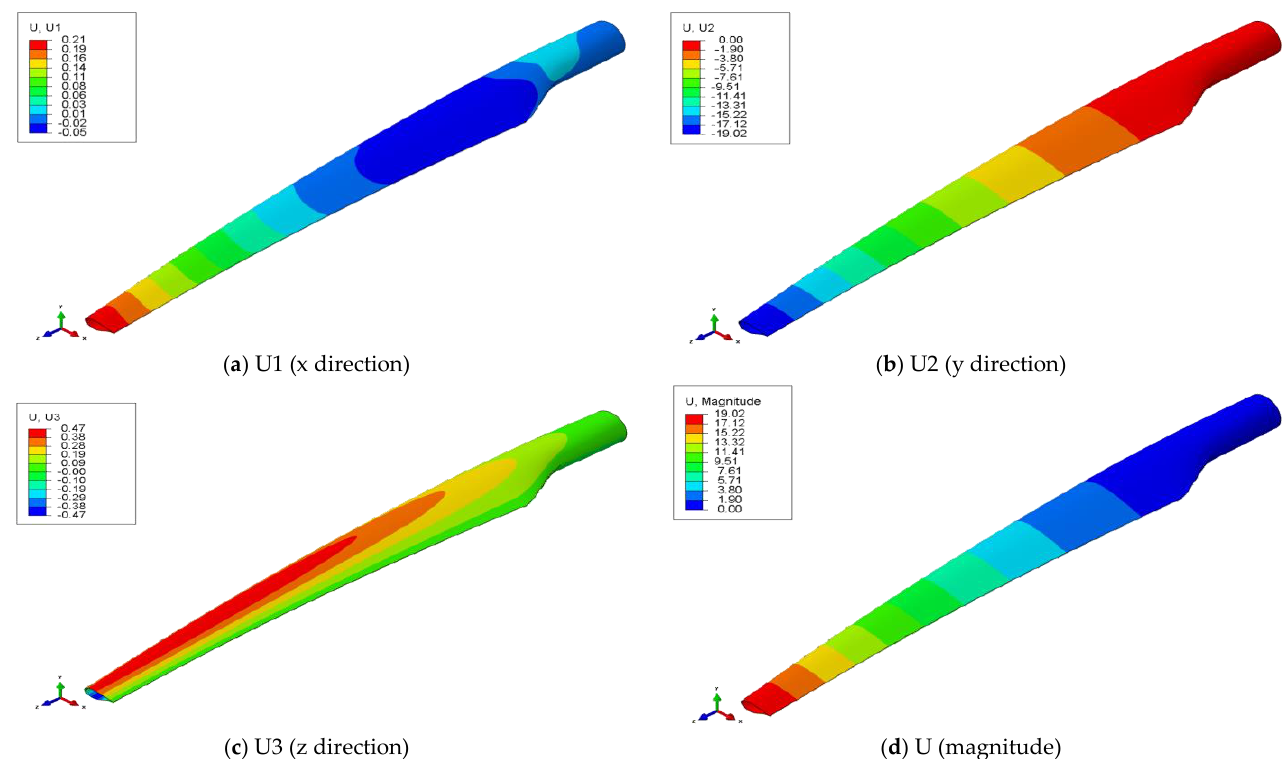
Figure 9. Distribution of displacement in case 2: ( a ) displacement in x direction; ( b ) displacement in y direction; ( c ) displacement in z direction; ( d ) total displacement. Table 2. The displacement values for each studied case.